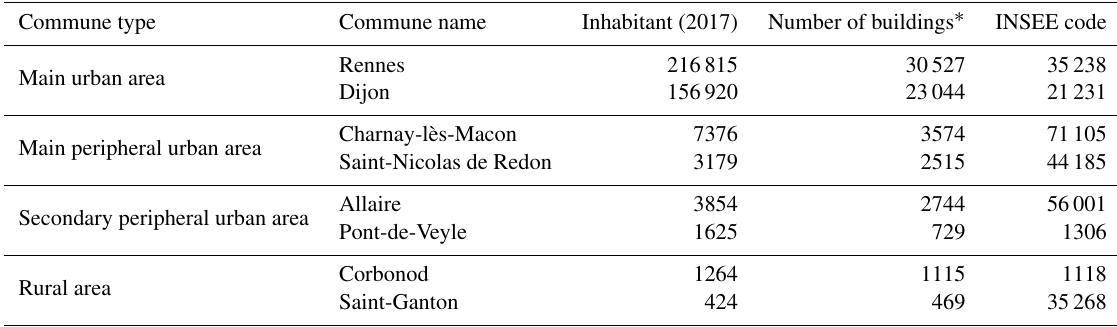
Table 3. Information and statistics about the validation dataset. Commune type